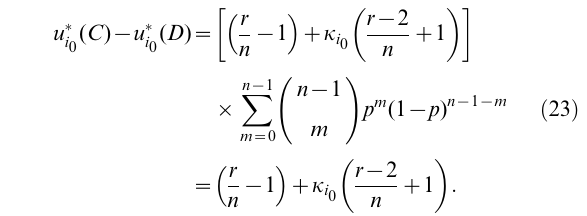
Table 4. The Public Goods Game.